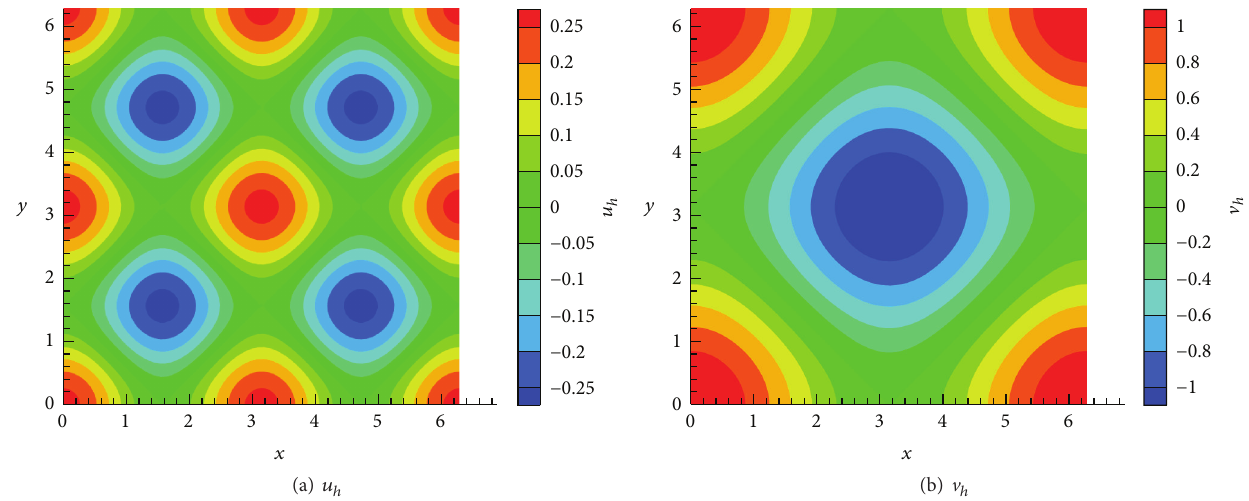
Figure 3: Graphs of numerical solutions 𝑢 ℎ and V ℎ at 𝑇 = 0.5 under the partition shown in Figure 2(a).